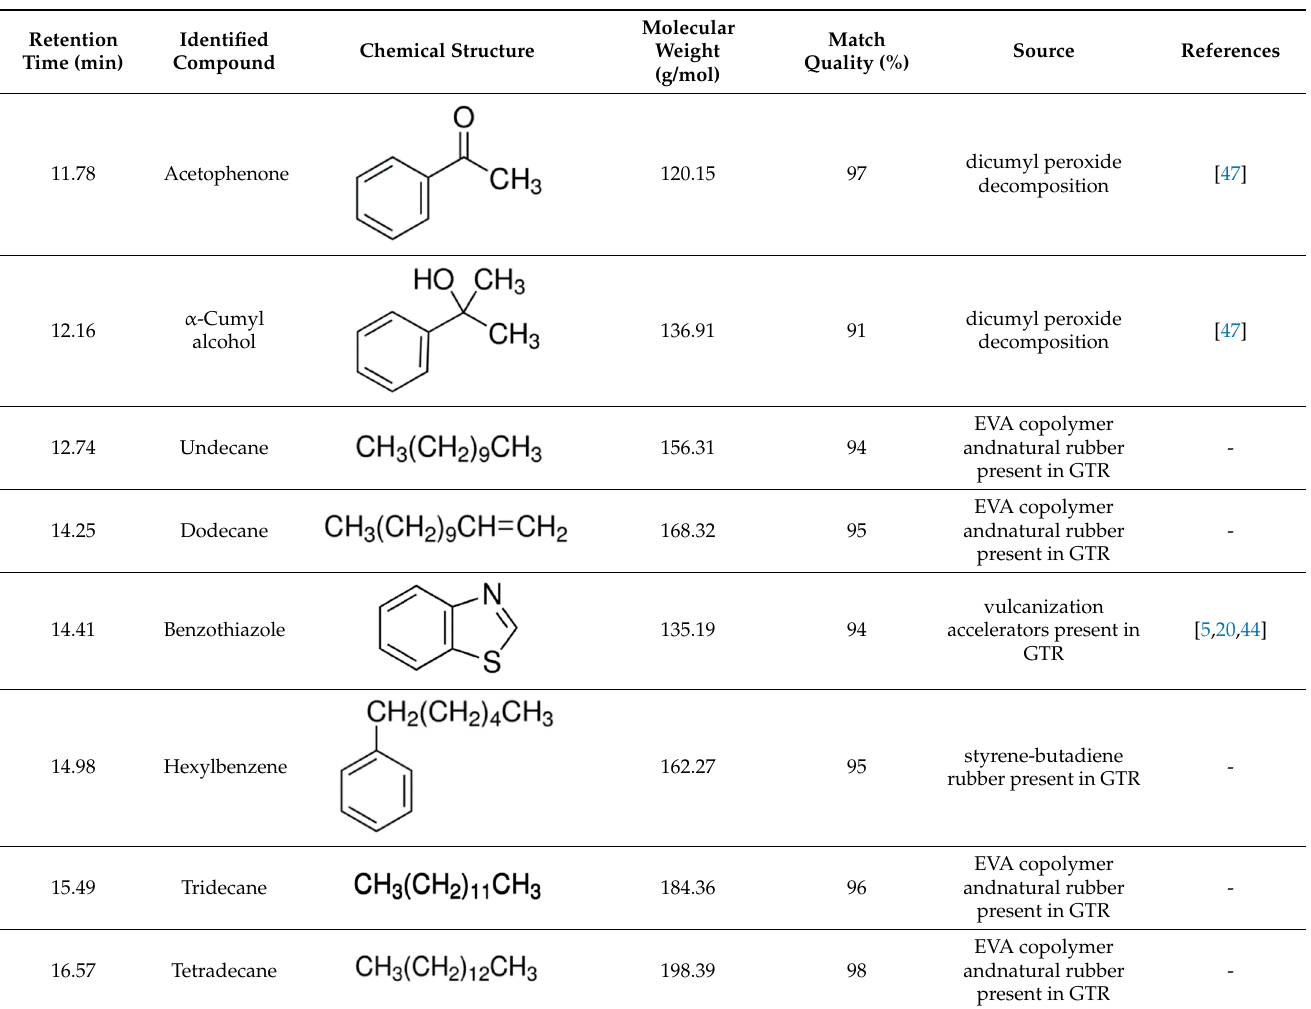
Figure 5. Mechanism of dicumyl peroxide decomposition.